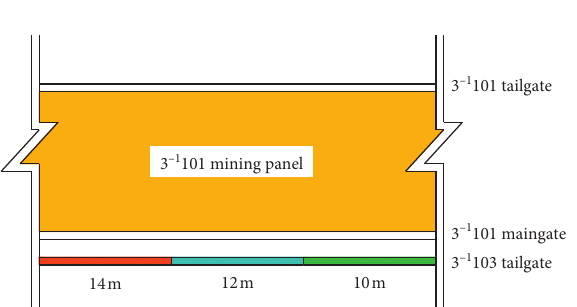
Figure 14: Roof cutting zone of the test section.